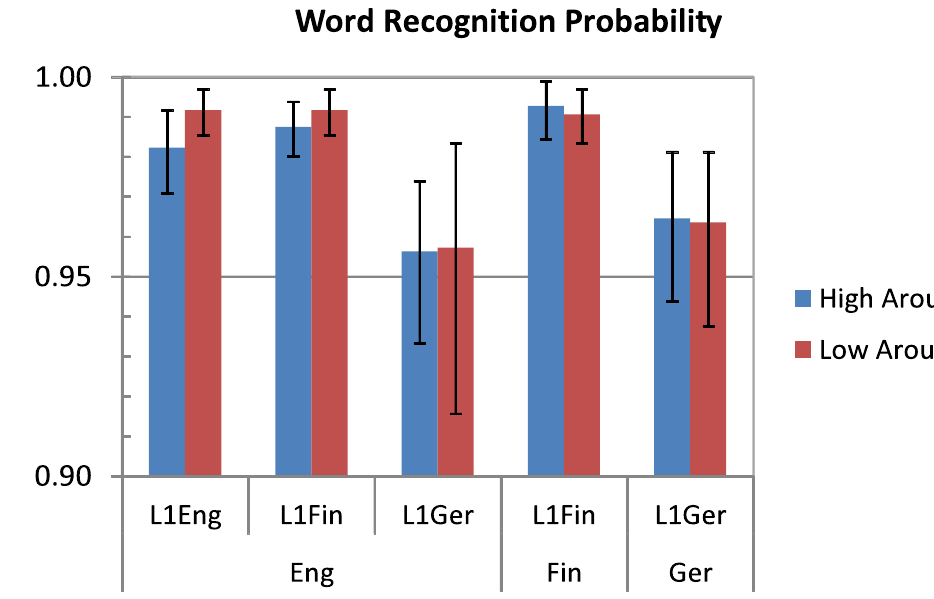
Fig 2. Probabilities of affirmative word recognition judgements. Broken down by Target Language (English, Finnish, or German–bottom labels on the X-axis), L1 of Participant (English, Finnish, or German), and Word Type (high arousal vs. low arousal). Error bars indicate bootstrapped 95% confidence intervals by participants.